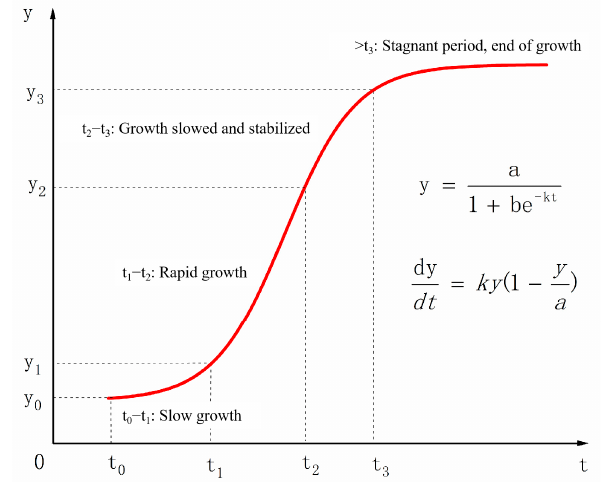
Figure 4. Schematic diagram of Logistic growth curve.